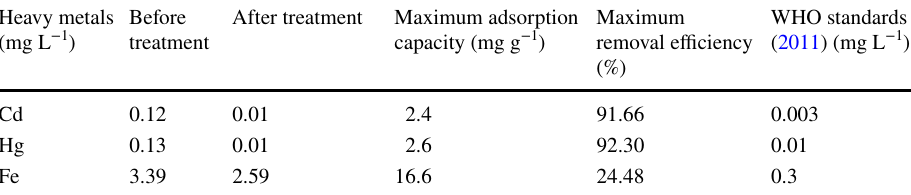
Cd Cadmium; Hg Mercury; Fe Iron; WHO World